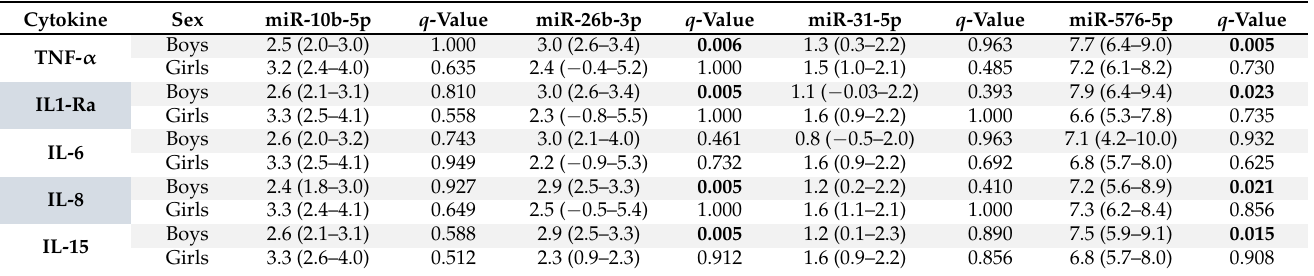
Table 3. Association of miRNA expression levels with selected cytokines (secondary